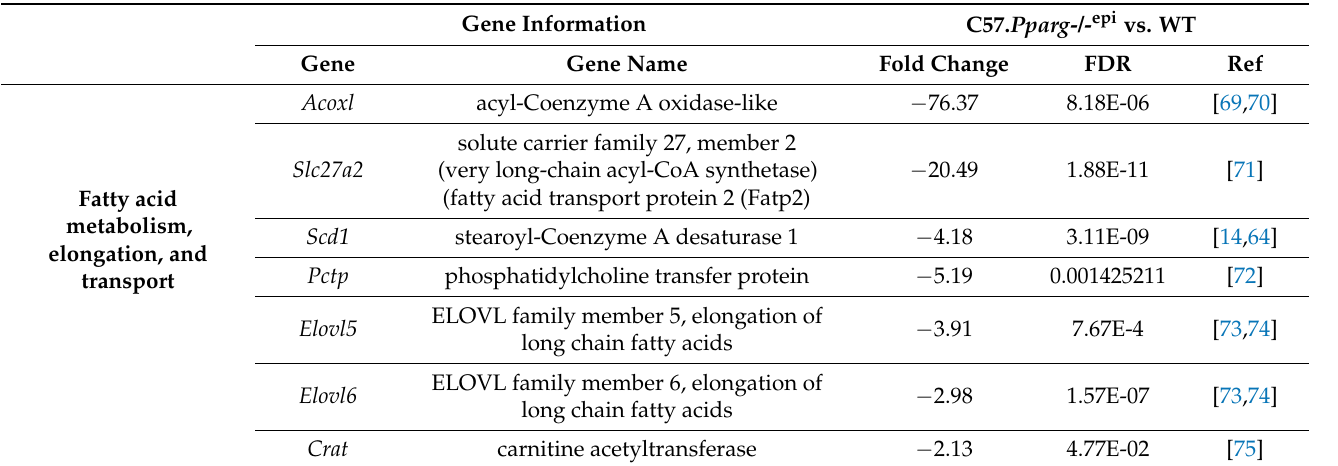
Table 2. Cont. Gene